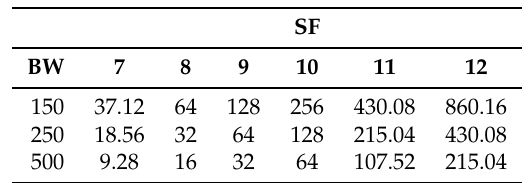
Table 5. Values of T packet (total transmission time of the LoRa packet), expressed in ms, versus BW and SF, with CR = 1, implicit header (IH = 1), CR = 1, cyclic redundancy check (CRC) = 1, payload of 10 bytes.